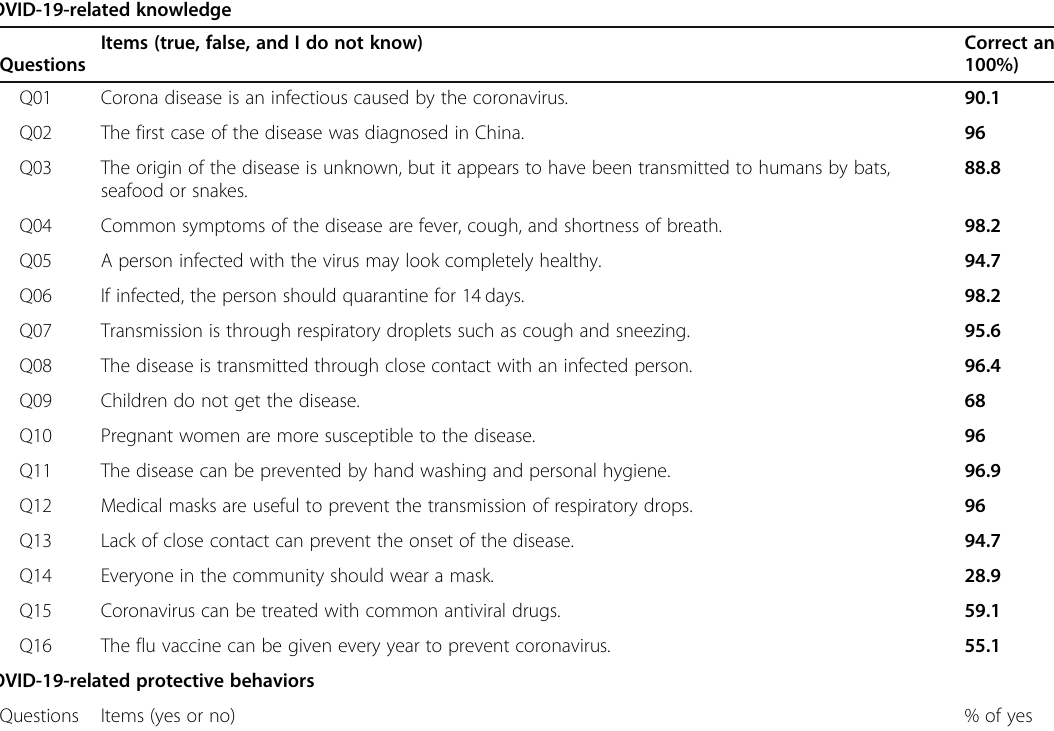
Table 1 Distribution of participants ’ responses to the items of knowledge and protective behaviors COVID-19-related